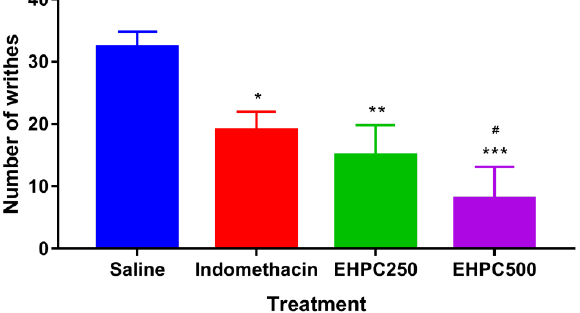
Figure 4. Writhing induced by the intraperitoneal administration of 0.8% acetic acid (10 mL/kg) in oral mice treated with 0.9% NaCl, indomethacin 10 mg/kg, EHPC 250 and 500 mg/kg. * p < 0.05; ** p < 0.01; *** p < 0.001 vs. NaCl; # p < 0.05 vs Indomethacin (ANOVA; Tukey).